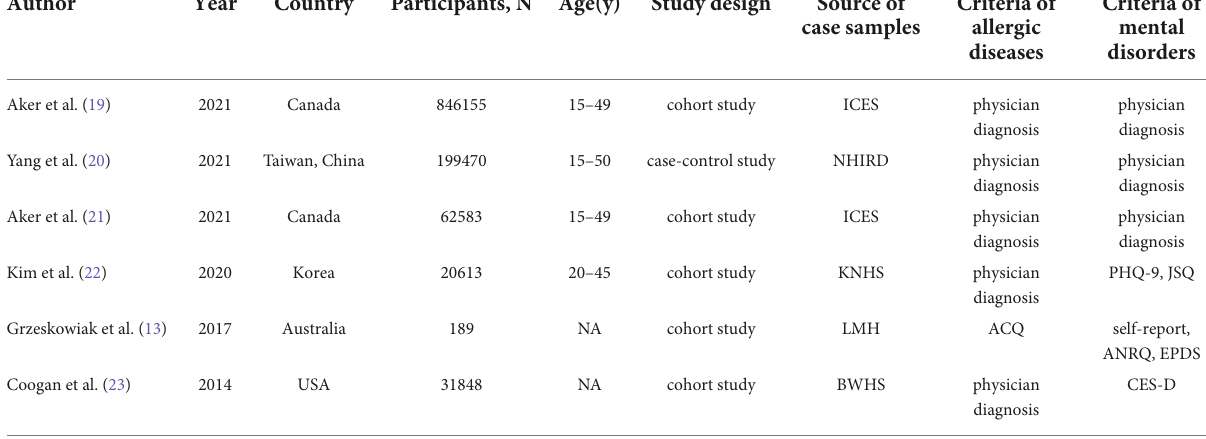
TABLE 1 Characteristics of 6 studies included in present study.